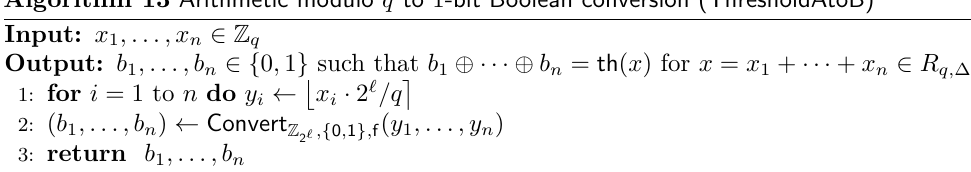
Algorithm 13 Arithmetic modulo q to 1 -bit Boolean conversion